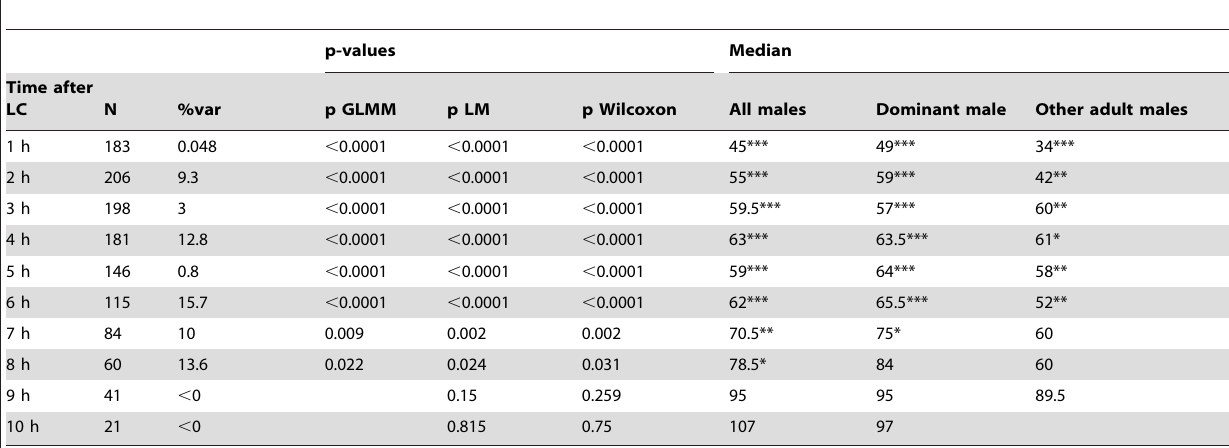
Table 1. Deviation angles between long call direction and travel direction after the first spontaneous long call of a day.